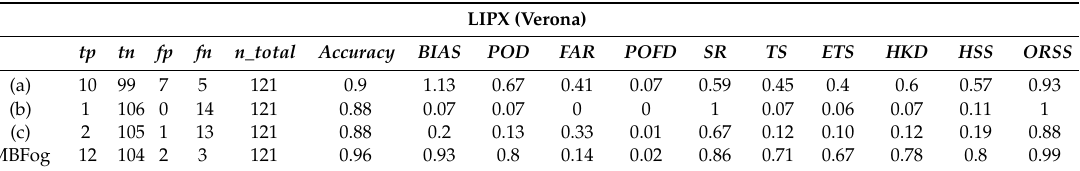
Table A4. Performances of several fog prediction methods for Verona site LIPX (Verona)